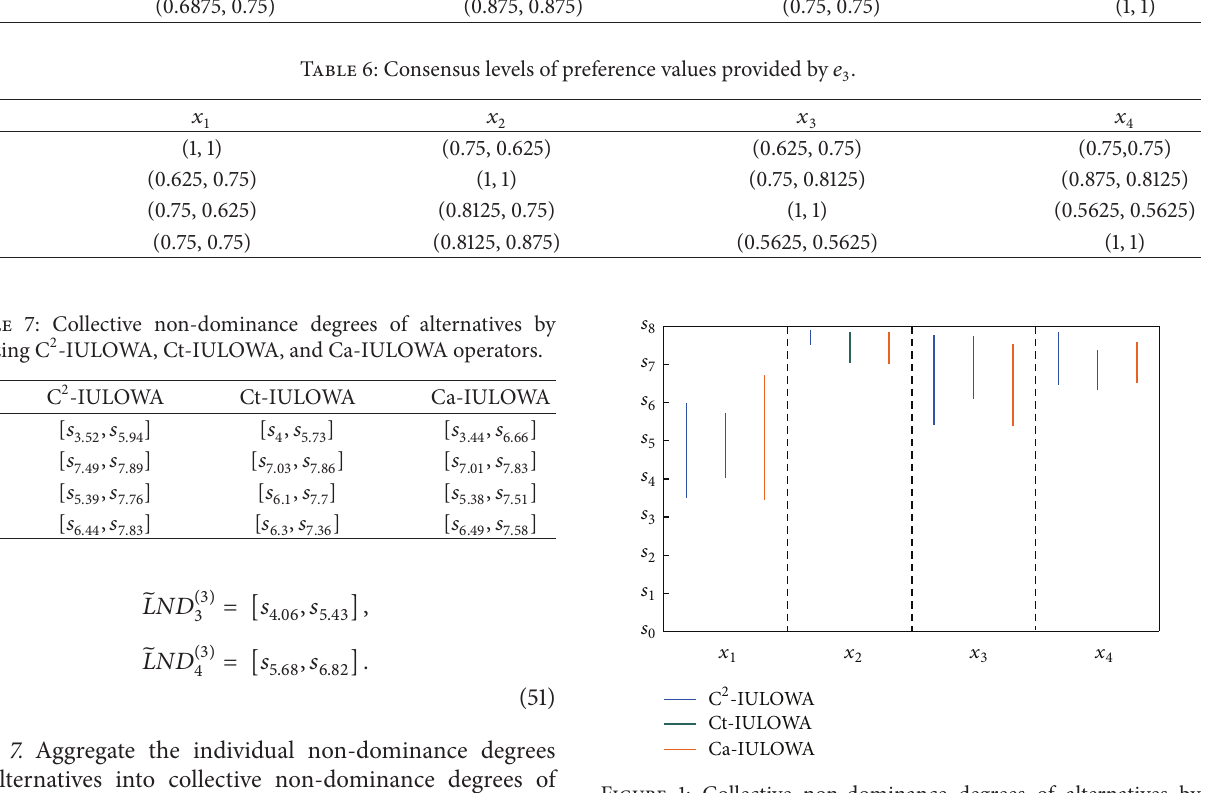
Figure 1: Collective non-dominance degrees of alternatives by utilizing C 2 -IULOWA, Ct-IULOWA, and Ca- IULOWA